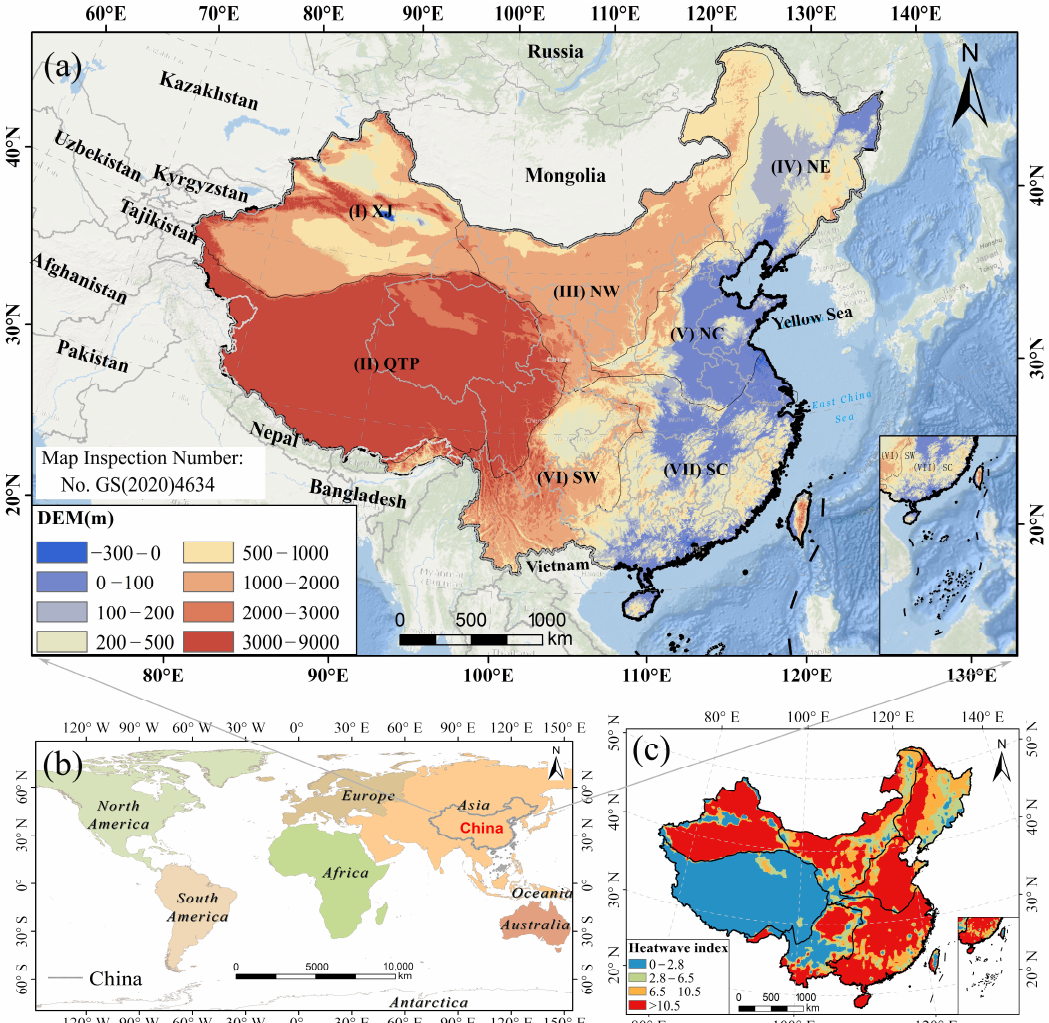
Figure 1. Map of China with seven subregions, including (I) Xinjiang (XJ), (II) Qinghai–Tibetan Plateau (QTP), (III) Northwest (NW), (IV) Northeast (NE), (V) North China (NC), (VI) Southwest (SW), and (VII) South China (SC). ( a ) The detailed geographical location and terrain of China, ( b ) the location of China in the world, and ( c ) the spatial distribution of the maximum heatwave index (HWI) in the 1979–2018 period, where higher values indicate warmer regions.